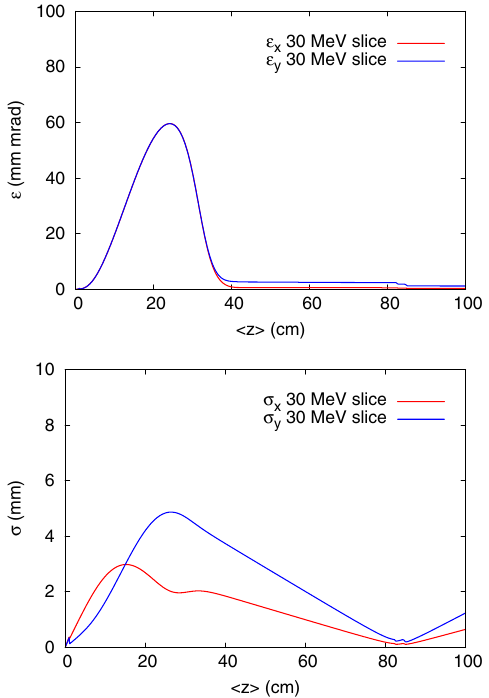
, (cid:8) in x y FIG. 6. Upper frame: Plot of the transverse emittances (cid:8) mm mrad as a function of h z i in cm for an energy selection of the beam 3 < E < 60 MeV . Lower frame: Plot of the rms beam , (cid:4) in mm for the same energy sizes (cid:4) x y